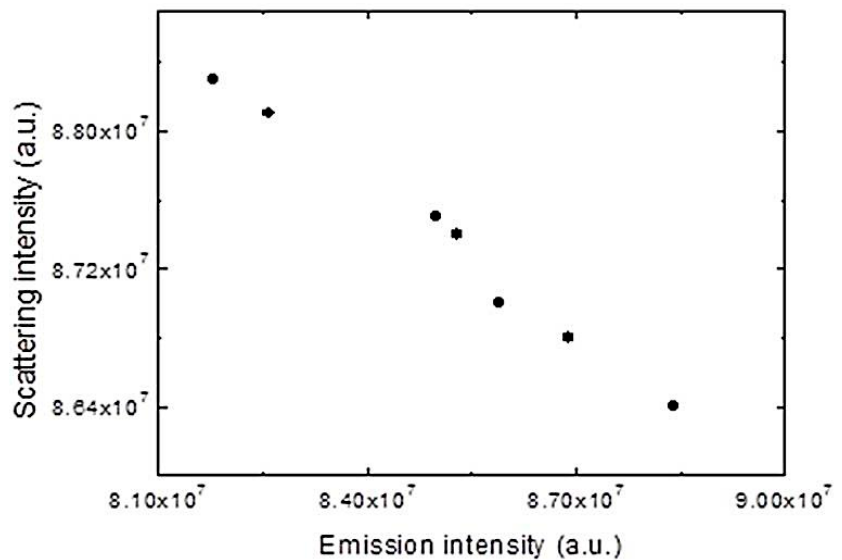
Figure 7. Plot of light scattering at 500 nm against fluorescence intensity at the emission maximum (415 nm) upon injecting a solution of PBS-PFP3 in 50% methanol-water into pure water.